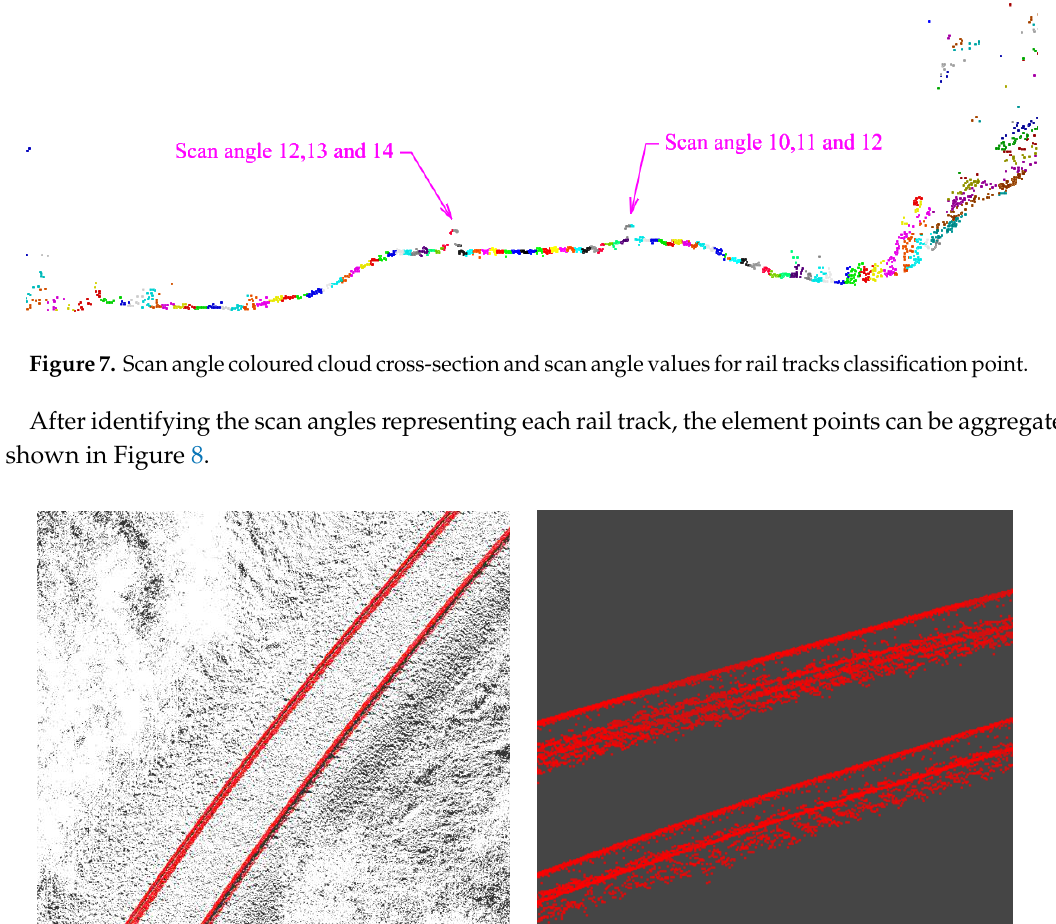
Figure 6. Example of a three-dimensional line extracted, representing the sensor trajectory.